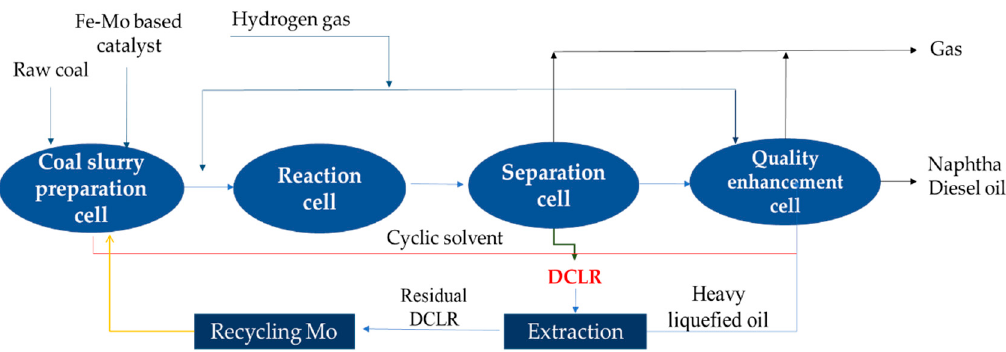
Figure 8. Processes to prepare the DCLR and recycling M O -based product from residual DCLR.